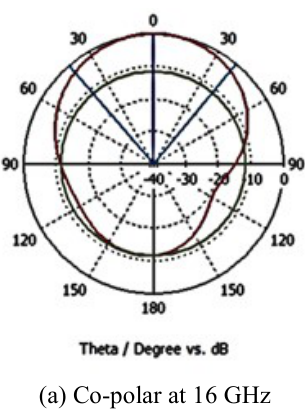
The normalized radiation patterns have been shown in fig. 8. The co-polar and cross-polar components have been shown in polar plots for YZ-plane.